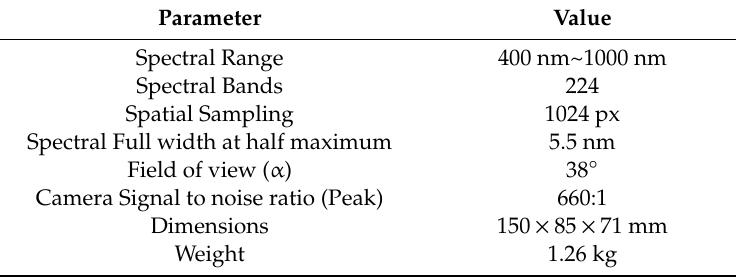
Figure 4. Soil image showing the “region of interest (ROI)” representing the average selected pixels: ( a ) hyperspectral image (specimen from Mt. Guryong), ( b ) remaining image, and ( c ) the region of interest in the granite soil.